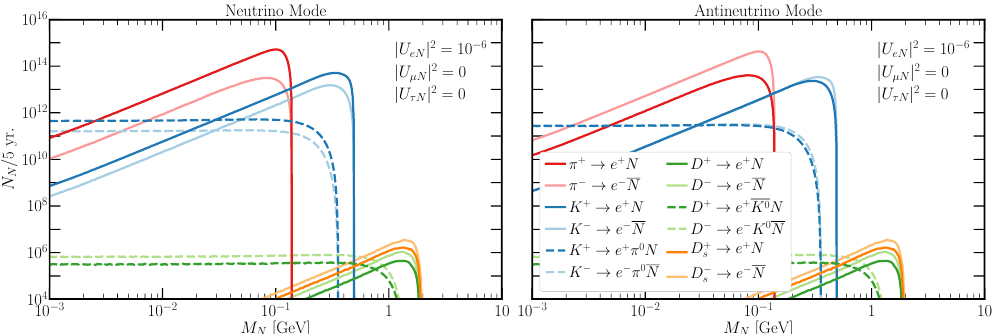
Figure 18 . Number of electron-coupled heavy neutral leptons N traveling toward the DUNE MPD as a function of mass M N , assuming (cid:12)ve years of data collection in neutrino mode (left) 2 = 10 (cid:0) 6 . Di(cid:11)erent meson-decay contributions or antineutrino mode (right). We have (cid:12)xed U eN j j are indicated by di(cid:11)erent colors: pions (red), kaons (blue), D mesons (green), and D s mesons (orange). For each meson, darker colors indicate positively-charged meson decays, where fainter colors indicate negatively-charged meson decays. Dashed curves indicate three-body meson decays.